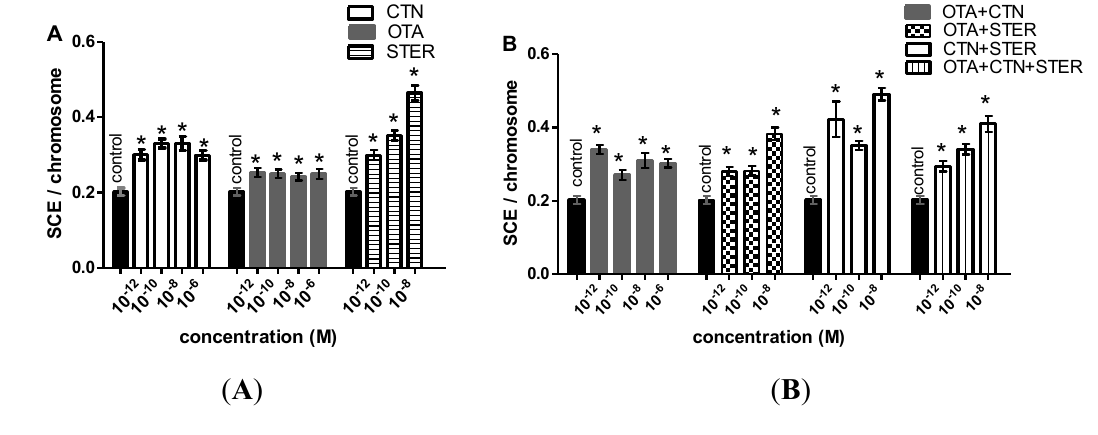
+ OV + OV ) – (N − 1) × OV 1 2 3 control